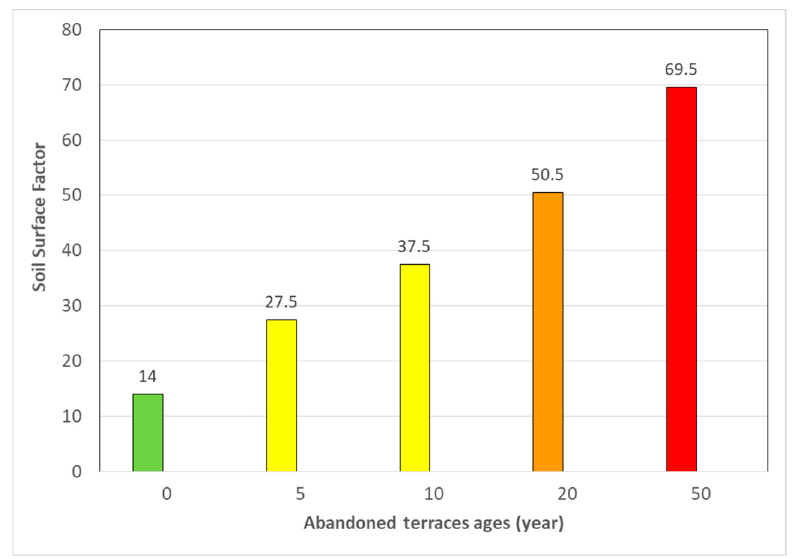
Figure 5. The average change in the SSF according to the years of abandonment of the terraces in the hamlets of Tizerkine and Timzemzit, Ait Baha, Western Anti-Atlas, Morocco.